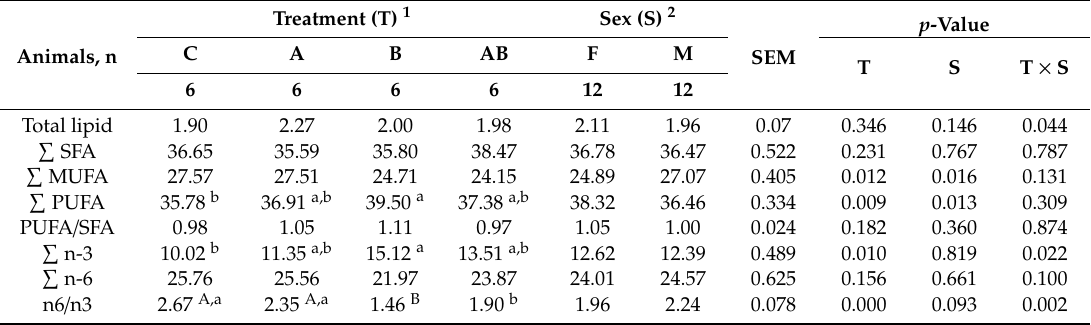
Table 6. E ff ect of the treatment and sex on total lipid (g / 100 g) and fatty acid profiles (% of total fatty acids) of breast muscle from Kuroiler chickens reared under tropical climatic